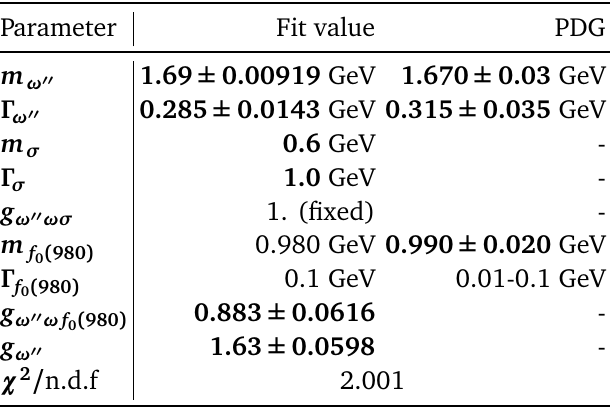
Table 8: Fit values for the ωππ